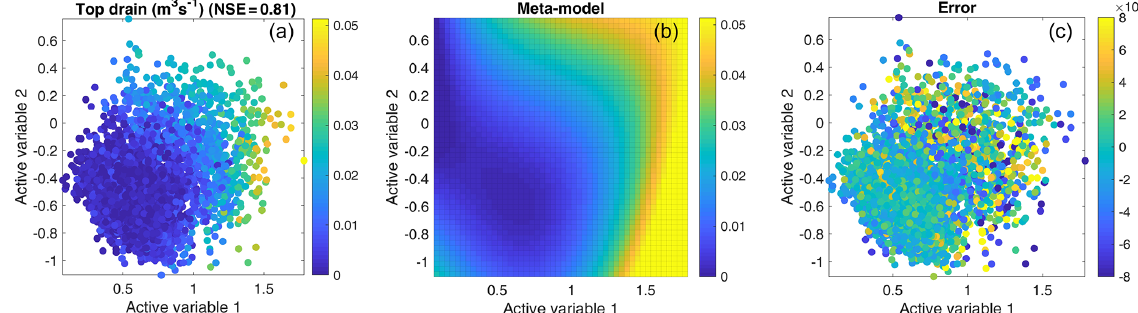
Figure 5. An example of the performance of the adaptive sampler for the top drain observation (limited flooding target). (a) shows the data; (b) the third-order polynomial meta-model fitted to the 10000 observations in (a) . (c) shows the error between the true observations and the meta-model fit.